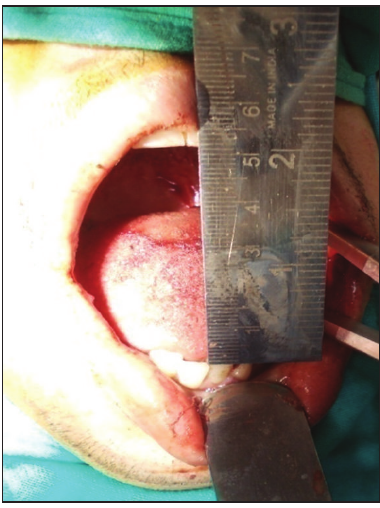
Figure 2: Intraoperative mouth opening.